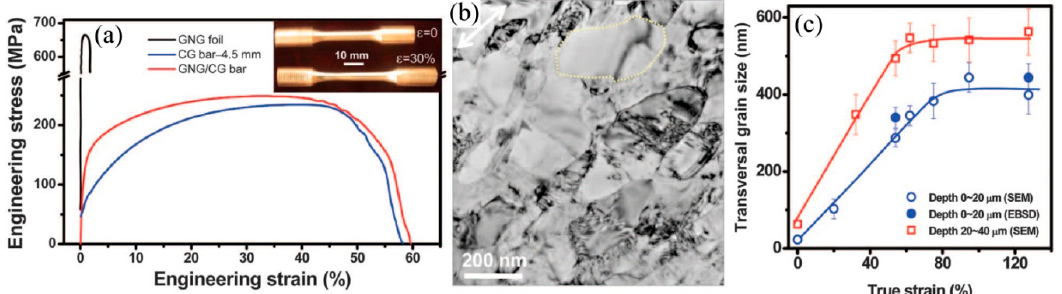
Figure 5. Tensile properties and corresponding deformation mechanisms of gradient grained copper: ( a ) Engineering stress–strain curves; ( b ) TEM image of the top layer after a true tensile strain of 33% showing "in-situ" coarsened dislocation-free grains; ( c ) Variation of average grain sizes with applied tensile strain for the gradient layer. Adapted from [42].